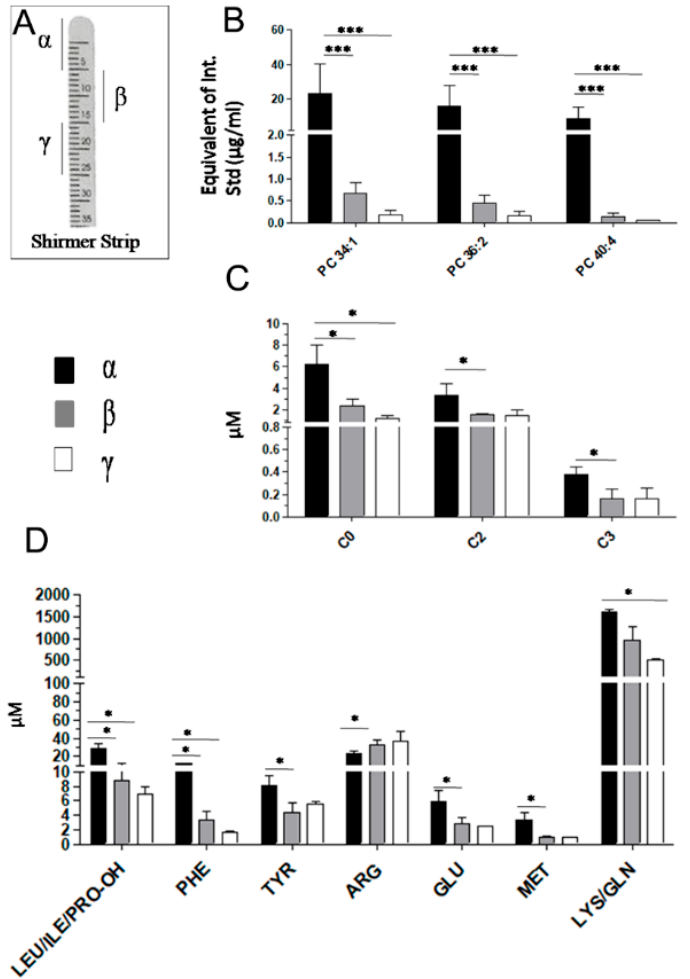
Figure 1. Study of metabolites distribution in paper strip. ( A ) Figure shows the amount of metabolites measured in three sections of 10 mm called α , β and γ to determine whether the metabolites are evenly distributed along the strip. ( B ) Histograms show the amount of PC 34:1, PC 36:2 and PC 40:4 expressed as equivalent of Internal Standard ( µ g/mL) along the paper strip. ( C , D ) Panels show the concentration of free carnitine (C0), acyl carnitines (C2, C3) and amminoacids (Leu/Ile/Pro, Phe, Tyr,